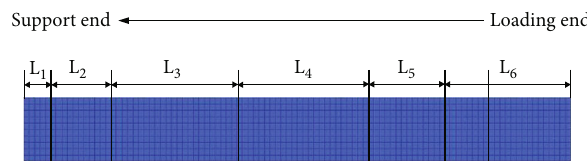
Figure 25: Con fi gurations of the TRB concept tube without transition